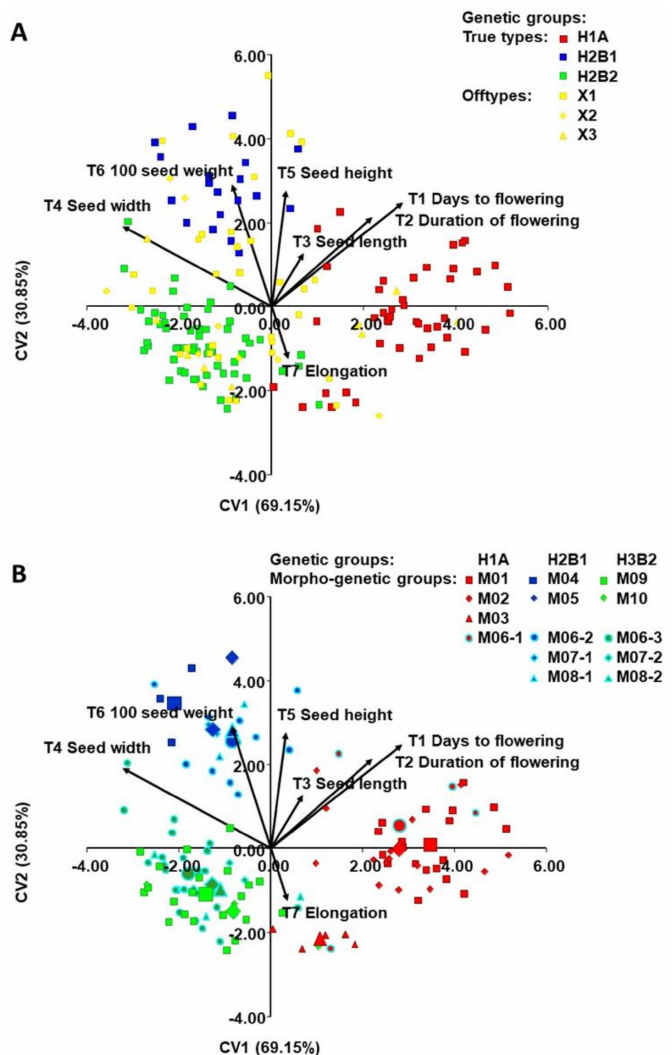
Figure 5. Discriminant analysis (DA) of Croatian common bean accessions based on seven mor- phological traits that were the most useful for maximum discrimination between three true-type genetic groups (H1A, H2B1, H3B2) groups: ( A ) Plot showing classification of accessions into three true-type genetic groups (H1A, H2B1, H3B2) and three off-type groups and ( B ) the same plot show- ing classification of true-type accessions into 14 morphogenetic groups (see Table 2). In B, each accession is indicated by a small sign, while the morphogenetic group barycenters (the average of morphogenetic groups) are represented by larger ones. The signs with light blue border indicate the morphotypes (landraces) that had been found in more than one genetic group and reclassified as different morphogenetic groups (M06 to M06-1, M06-2 and M06-3